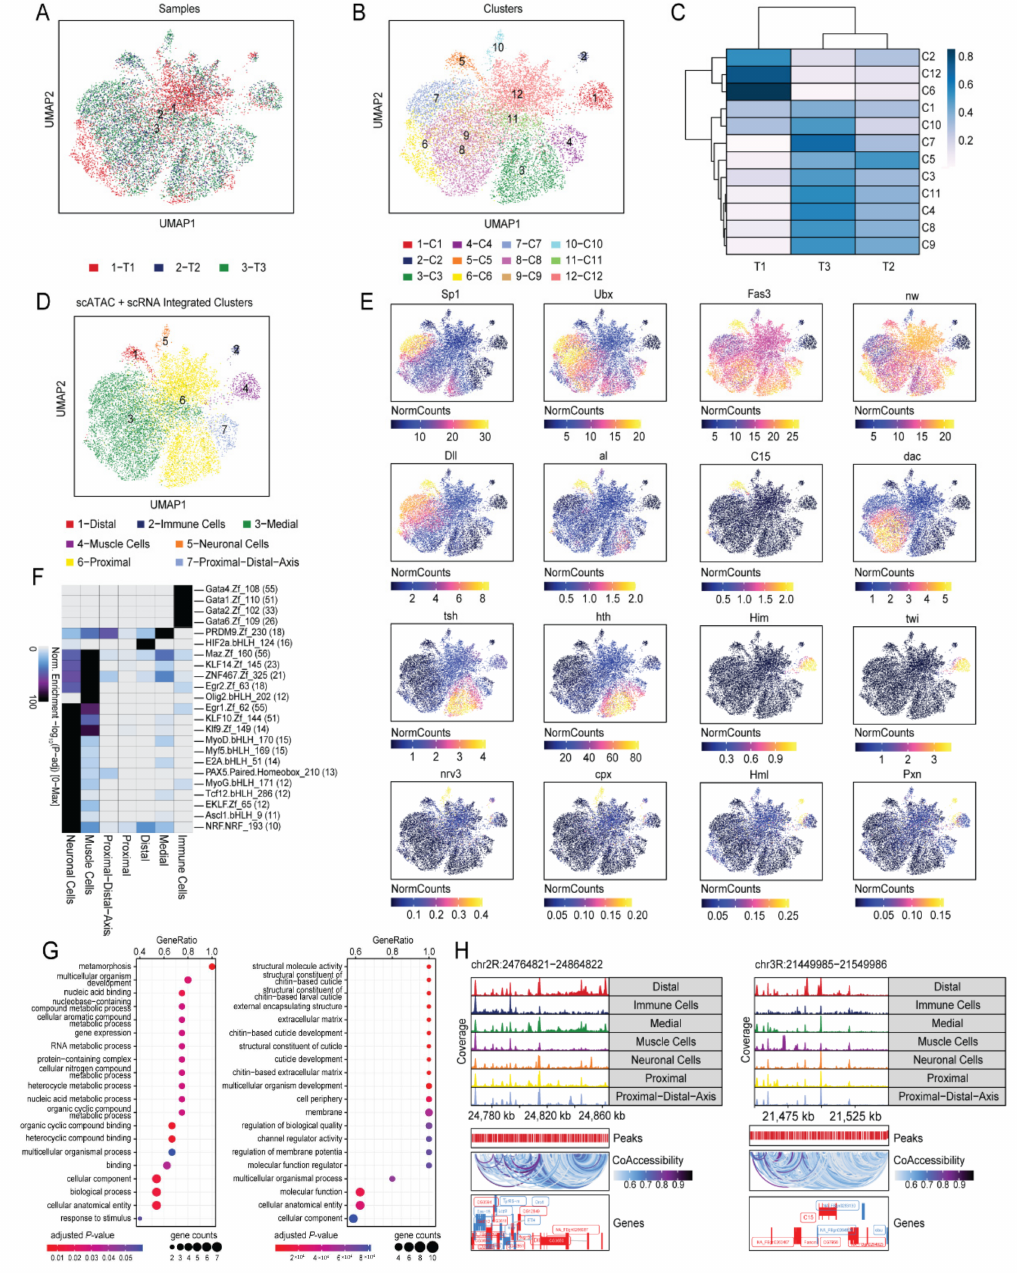
Figure 4. scATAC-seq revealed the same major cell types of Drosophila L3 disc as in scRNA-seq. ( A ) UMAP visualization of the scATAC-seq data, showing that T1, T2, and T3 overlay one